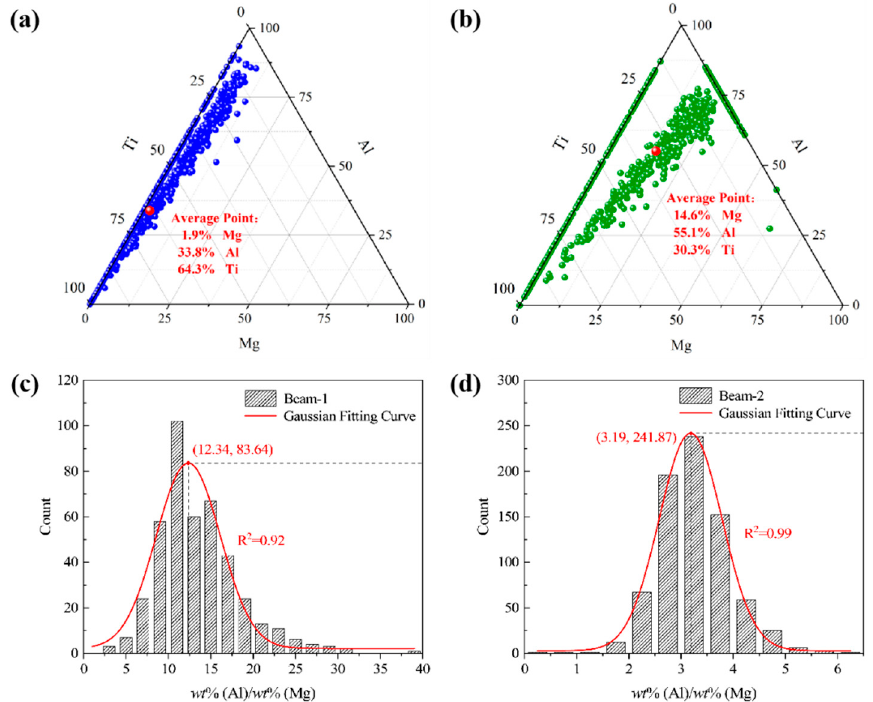
Figure 3. Composition distribution characteristics of the inclusions in Beam-1 steels ( a ) and Beam-2 steel ( b ); statistical histogram of Al/Mg mass ratio of (Al, Mg) Ti inclusions in Beam-1 steel ( c ) and Beam-2 steel ( d ).